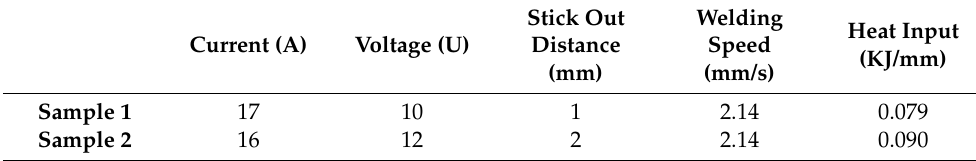
Table 2. Specific welding parameters for TIG.